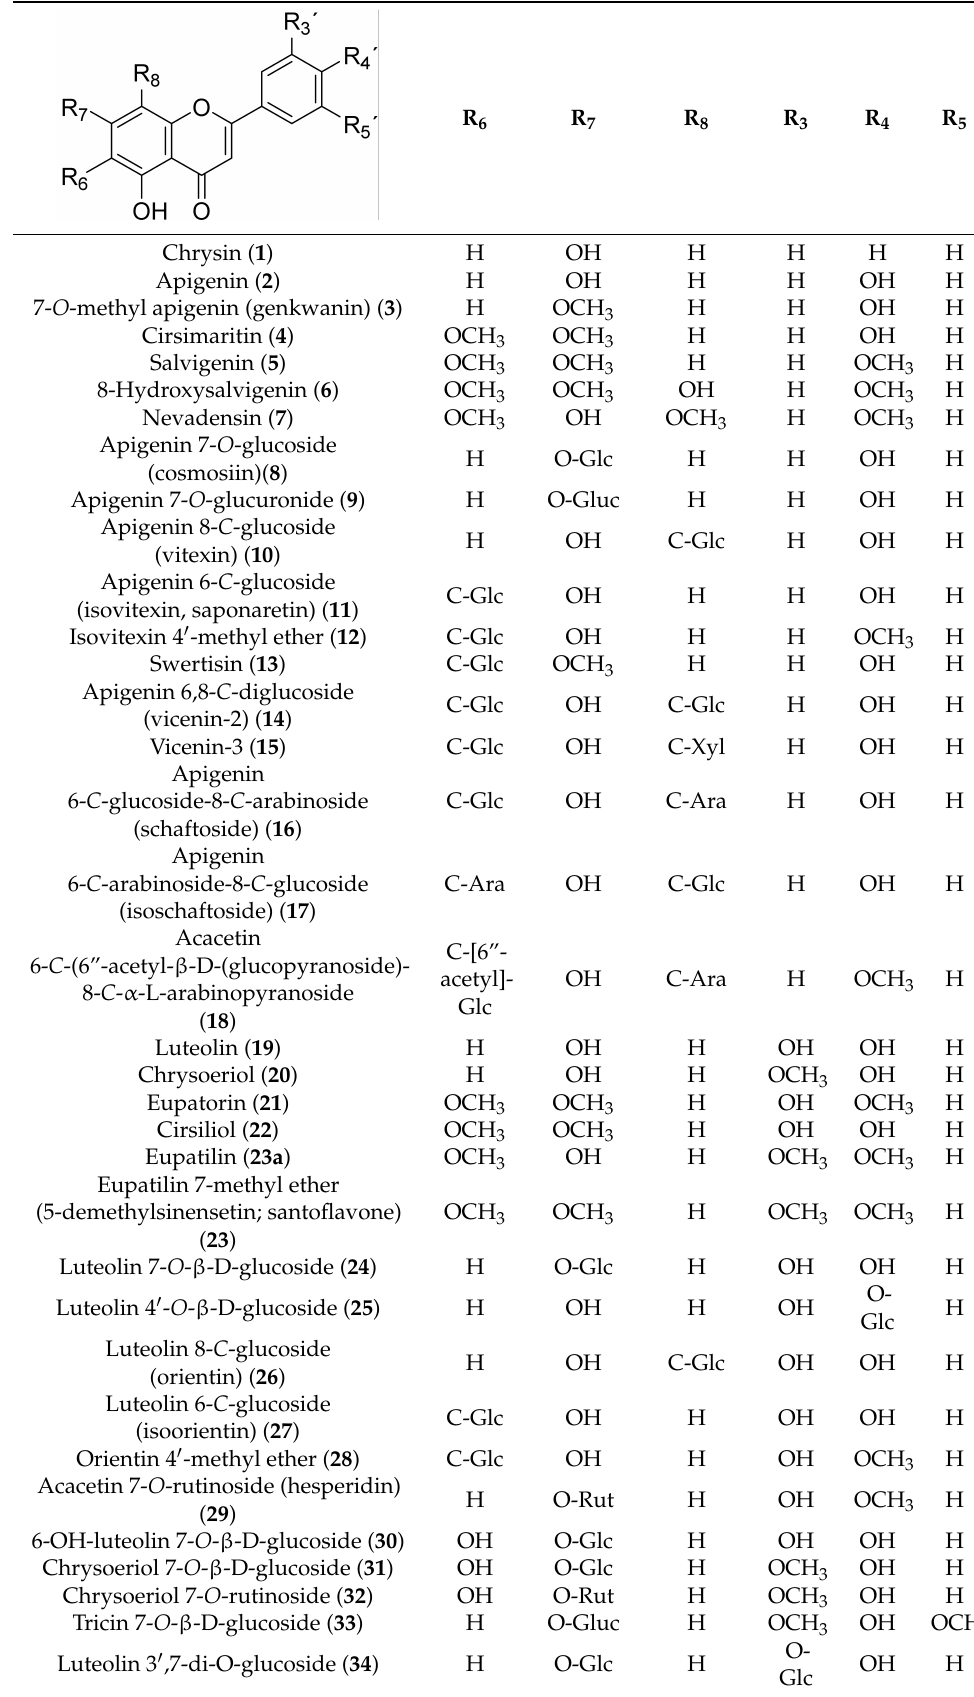
Table 3. Chemical structures of the flavone derivatives from Achillea